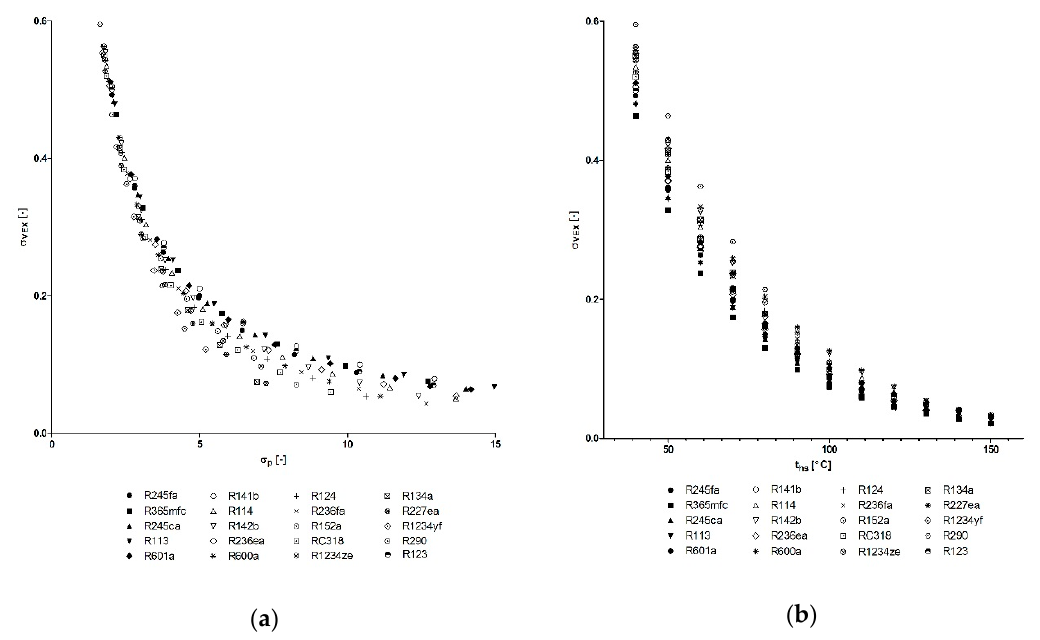
Figure 15. The variation of the σ VEX parameter vs. pressure expansion ratio and heat source temperature: ( a ) σ VEX = f( σ P ); ( b ) σ VEX = f(t hs ).